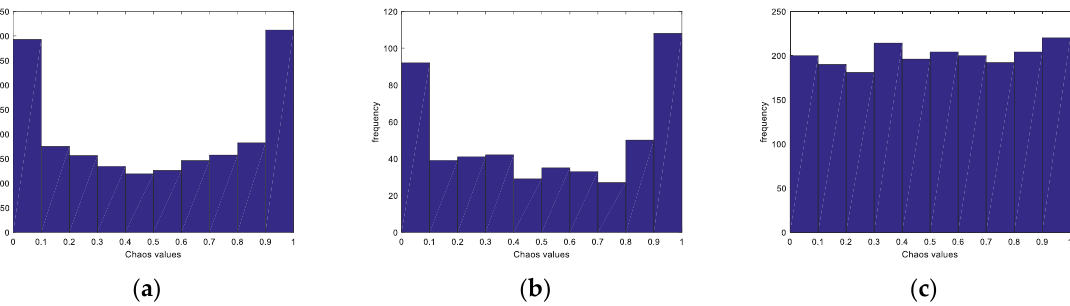
Figure 2. Chaotic Mapping Histogram. ( a ) Logistic mapping; ( b ) Sine mapping; ( c ) SPM mapping.